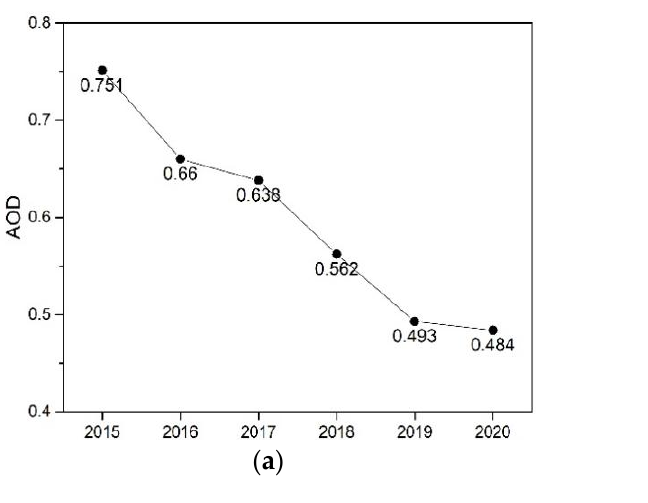
Figure 6. Description of MODIS AOD at 550 nm: ( a ) annual change trend graph of AOD; ( b ) monthly change trend graph of AOD from 2015 to 2020.